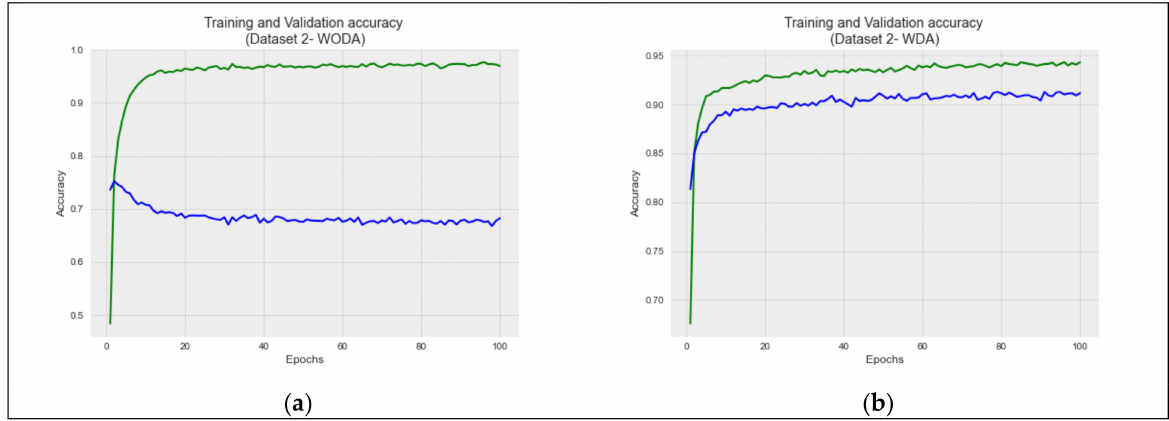
Figure 14. Bi-LSTM model validation and testing accuracy and loss (dataset 1): ( a ) model accuracy (WODA); ( b ) model accuracy (WDA).